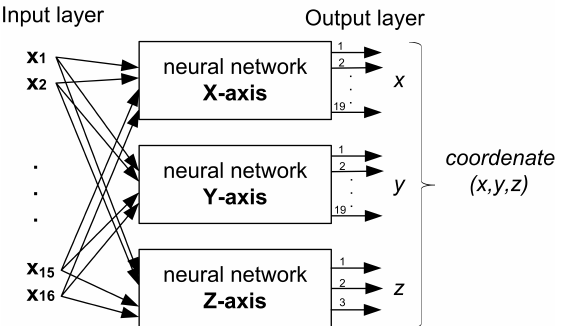
Figure 8. Proposed system based on three neural networks where each of them estimates the position in the axes X , Y , and Z